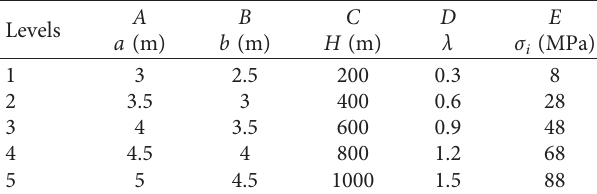
Table 2: Factors and levels of orthogonal numerical simulation